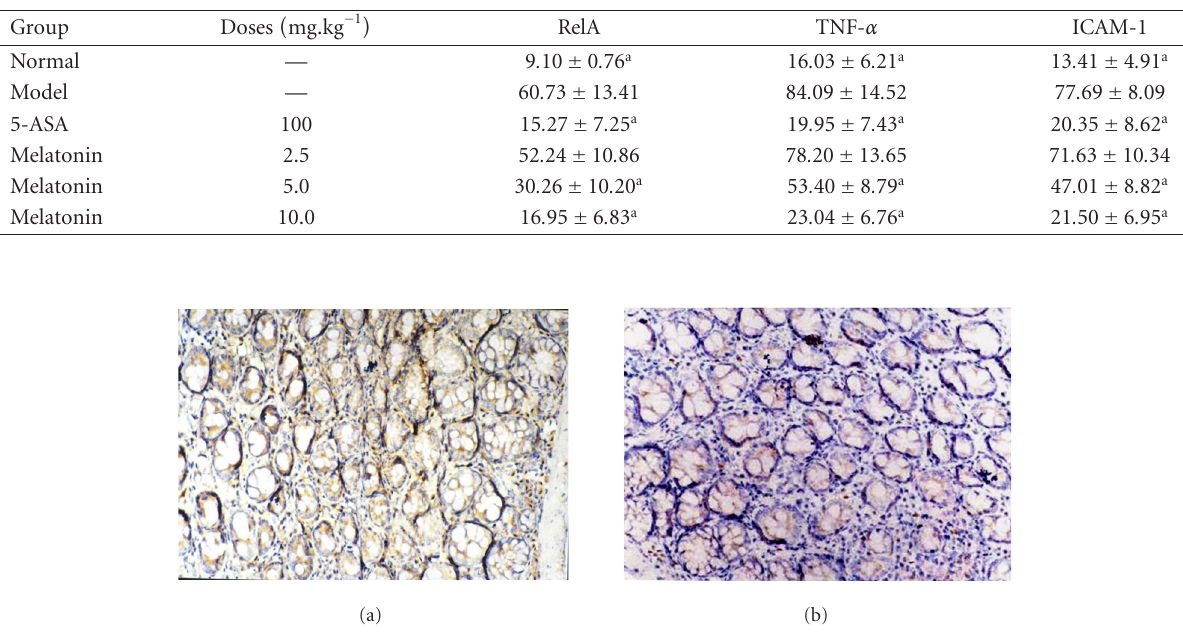
Table 2. E ff ects of melatonin and 5-ASA on protein expression of RelA, TNF- α , and ICAM-1 in colon tissue ( x ± s n = 10). a denotes that P < . 01 versus the model group.